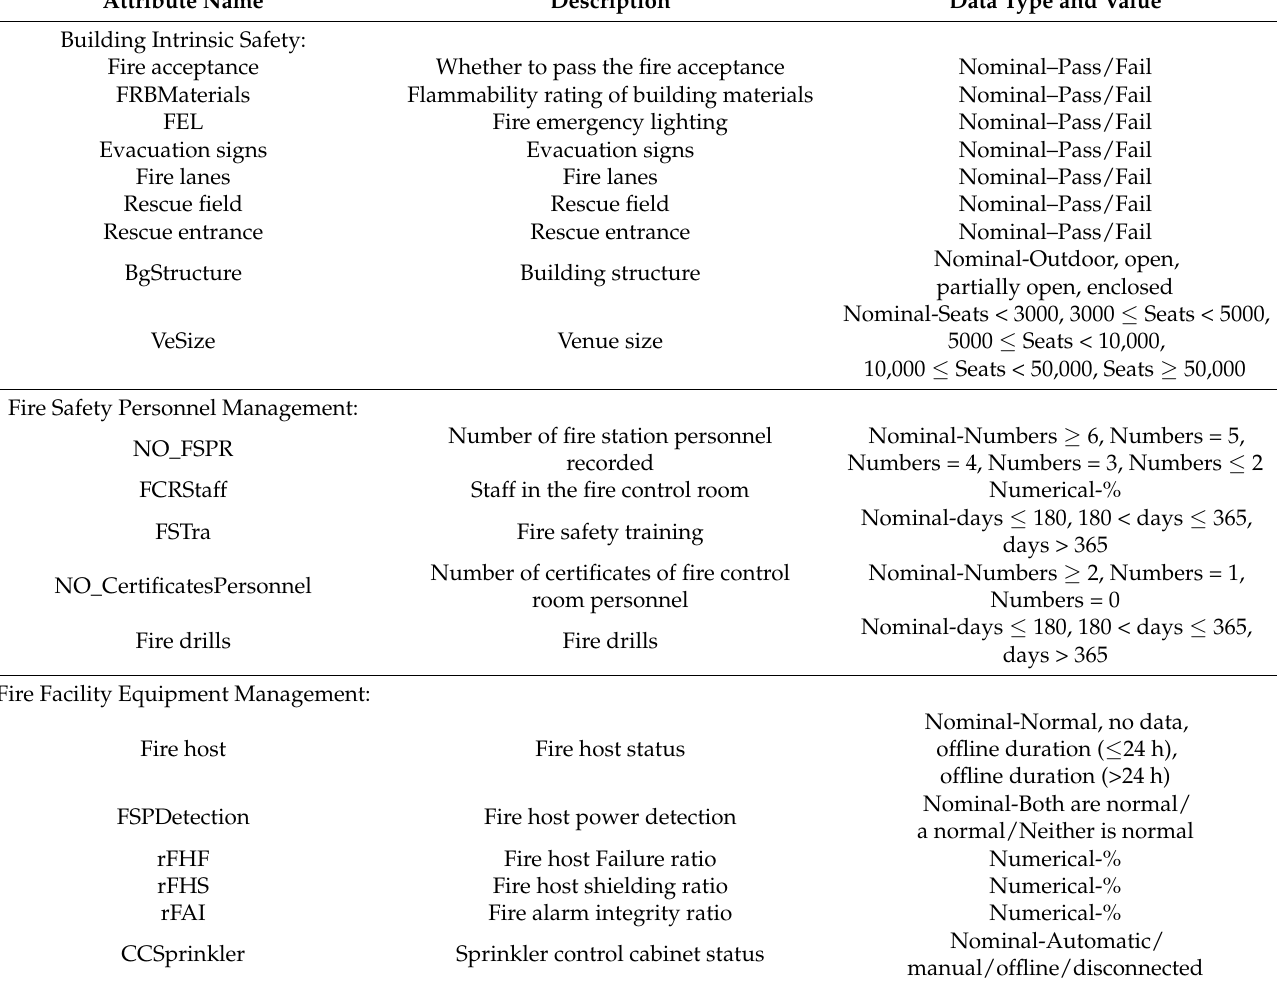
Table A1. Description of attributes from Stadium Fire Risk